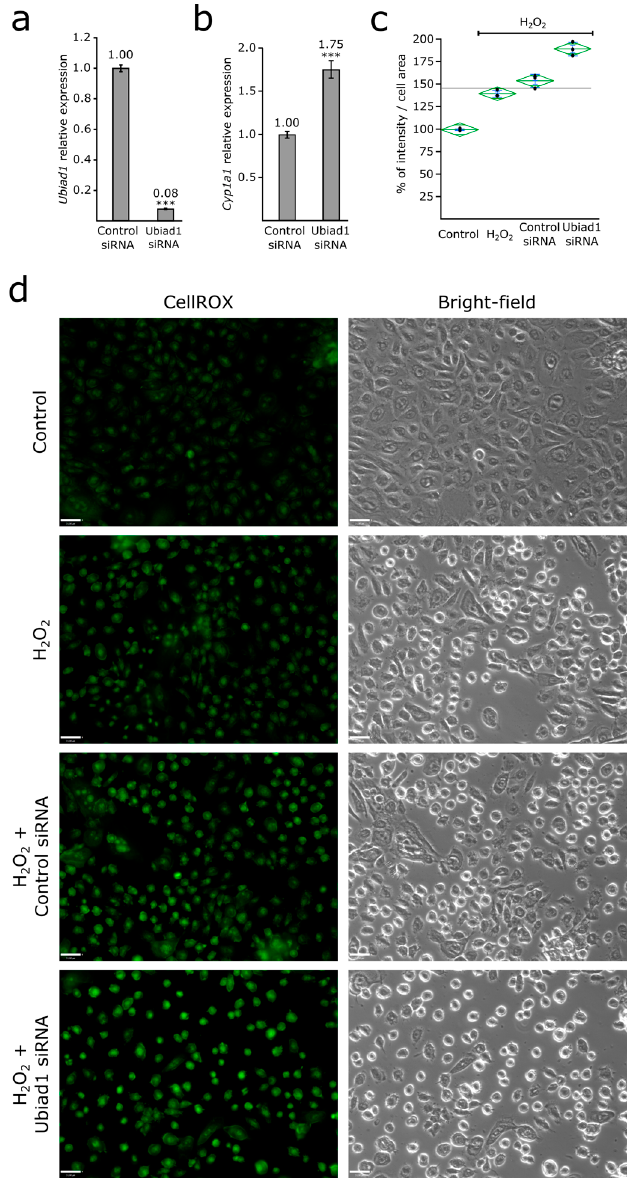
Figure 3. Implications of Ubiad1 in human keratinocyte physiology. ( a ) Relative quantification of Ubiad1 expression normalized to 18S reference gene, 48 h after Ubiad1 silencing (***: highly significant with Student's t test); ( b ) Relative quantification of Cyp1a1 expression normalized to 18S reference gene, 48 h after Ubiad1 silencing (***: highly significant with Student's t test); ( c ) CellROX quantification graph with One-Way Analysis of Variance, displaying confidence interval means diamonds (green). The line across each diamond represents the group mean. The vertical span of each diamond represents the 95% confidence interval for each group. Grand sample mean is represented by a horizontal black line; ( d ) Cellular ROS detection in keratinocyte exposed 30 min to 2 mM hydrogen peroxide using the CellROX green assay (×20 objective lens, scale bar = 31 µm).